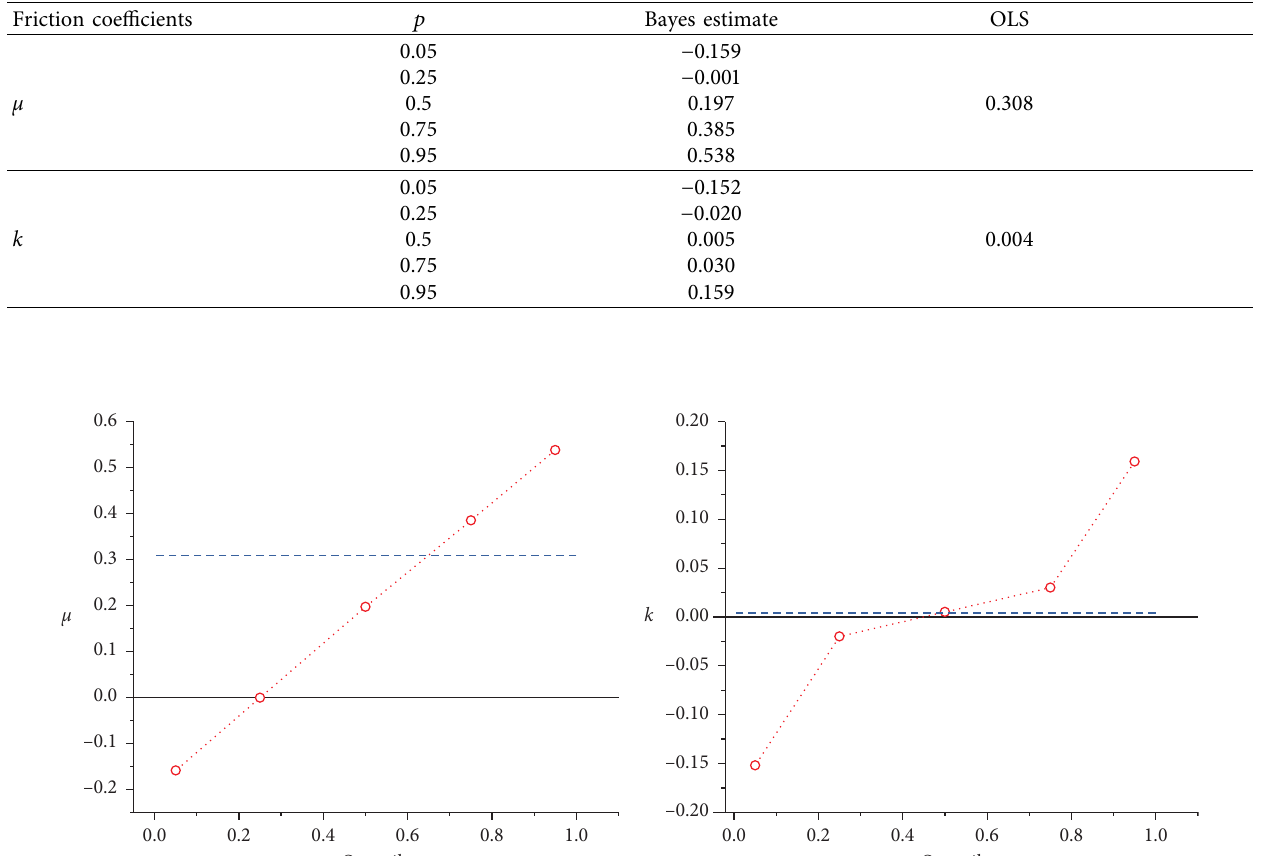
Table 4: Summary of friction coefficients.